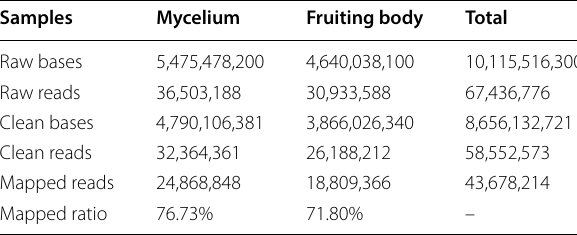
Table 1 Read and base numbers for the M.